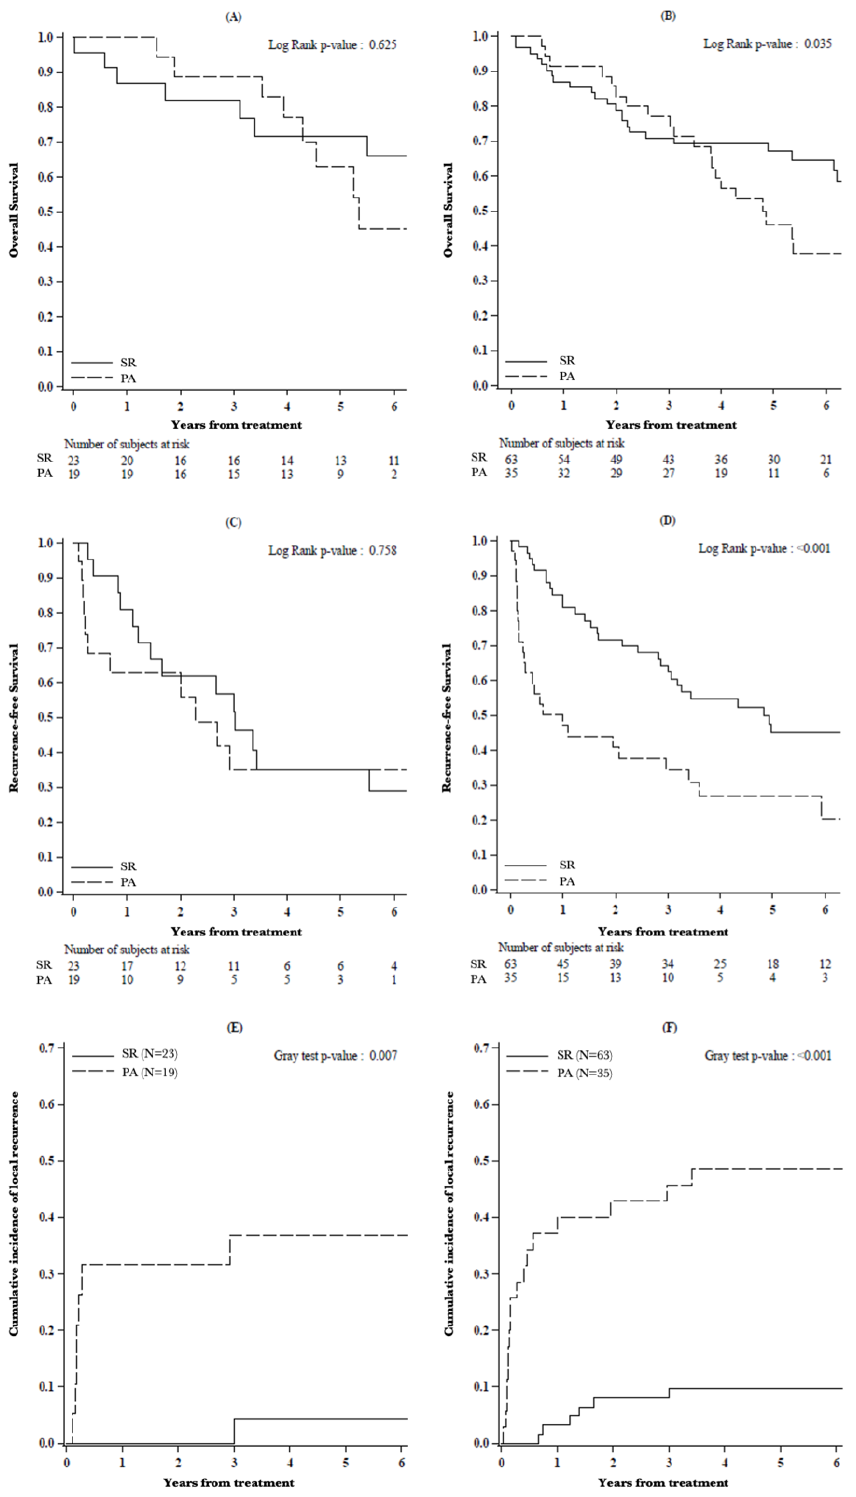
Figure 3. ( A , B ) Overall survival, ( C , D ) recurrence-free survival and ( E , F ) cumulative incidence of local recurrence in patients with nodule classified as ( A , C , E ) Li-RADS-3/4 and ( B , D , F ) Li-RADS-5, by type of treatment.